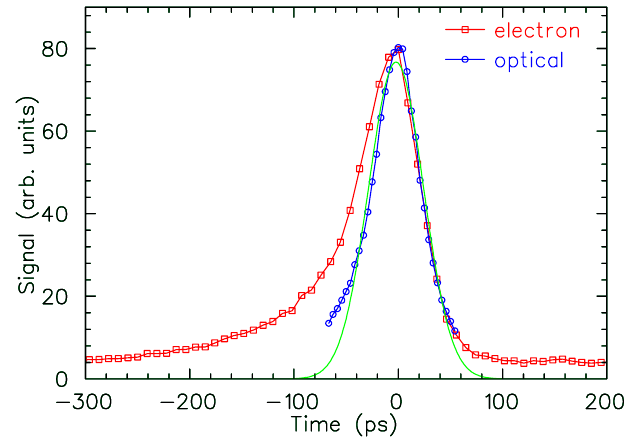
FIG. 8. (Color) Comparison of the optical pulse width and the electron bunch length at low current. The green curve is a 52 ps FWHM Gaussian fit to the optical pulse as measured by auto-